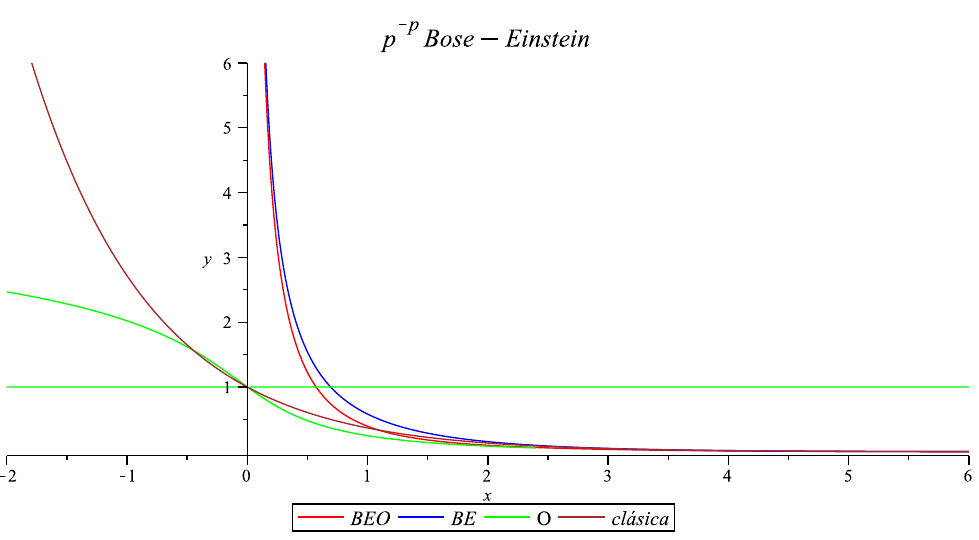
( β E ) . The red line l II